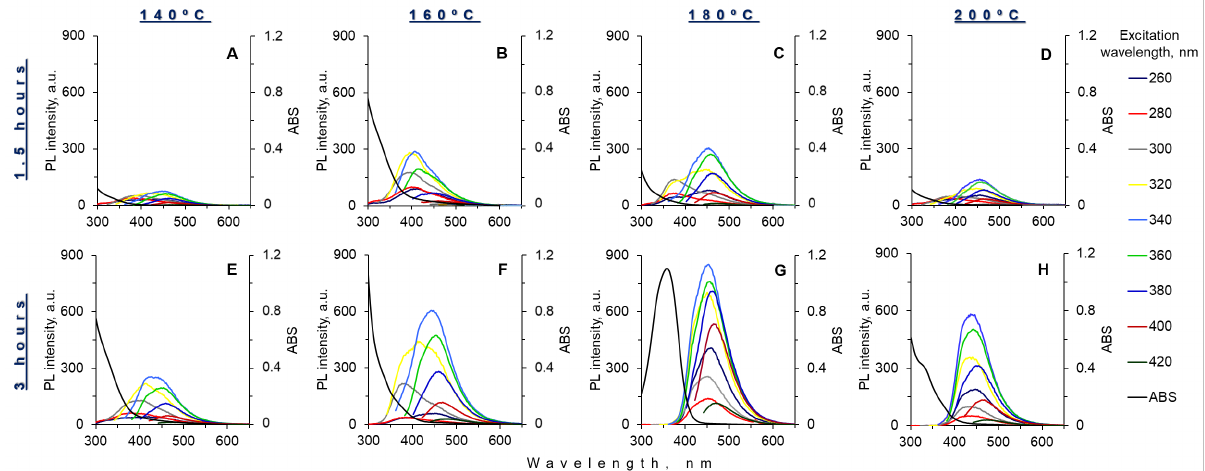
Figure 4. Absorbance and luminescence spectra of composite nanoparticles obtained by hydrothermal synthesis at 140 ◦ C ( A , E ), 160 ◦ C ( B , F ), 180 ◦ C ( C , G ) and 200 ◦ C ( D , H ) for 1.5 h and 3 h,